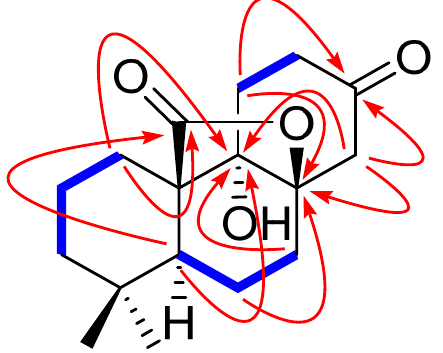
Figure 2. Key 1 H- 1 H COSY (blue and bold) and HMBC (red arrows) correlations of 1 .